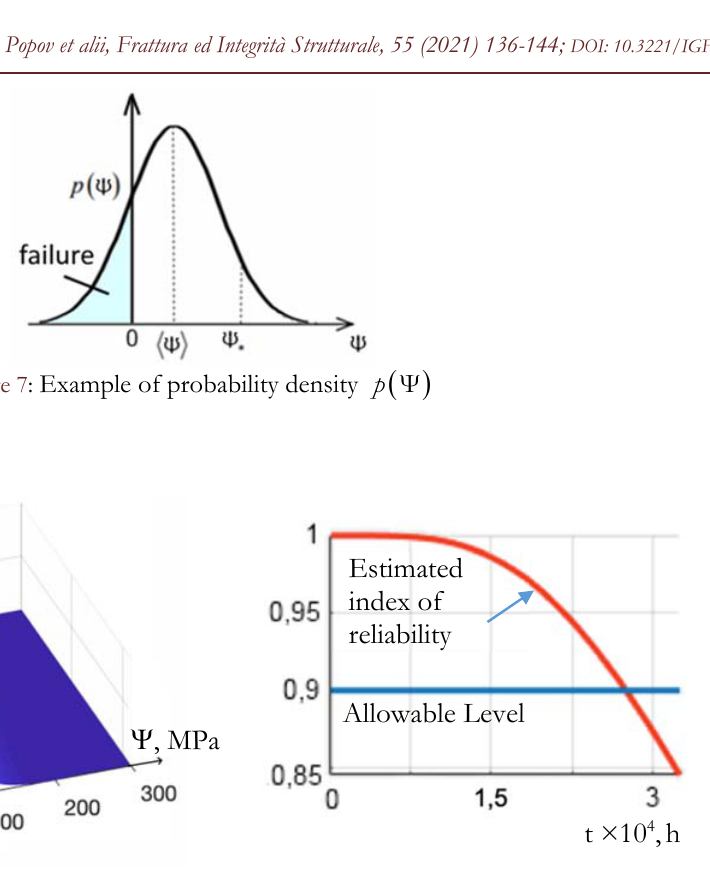
Figure 8: Example of probability density dependence function on time